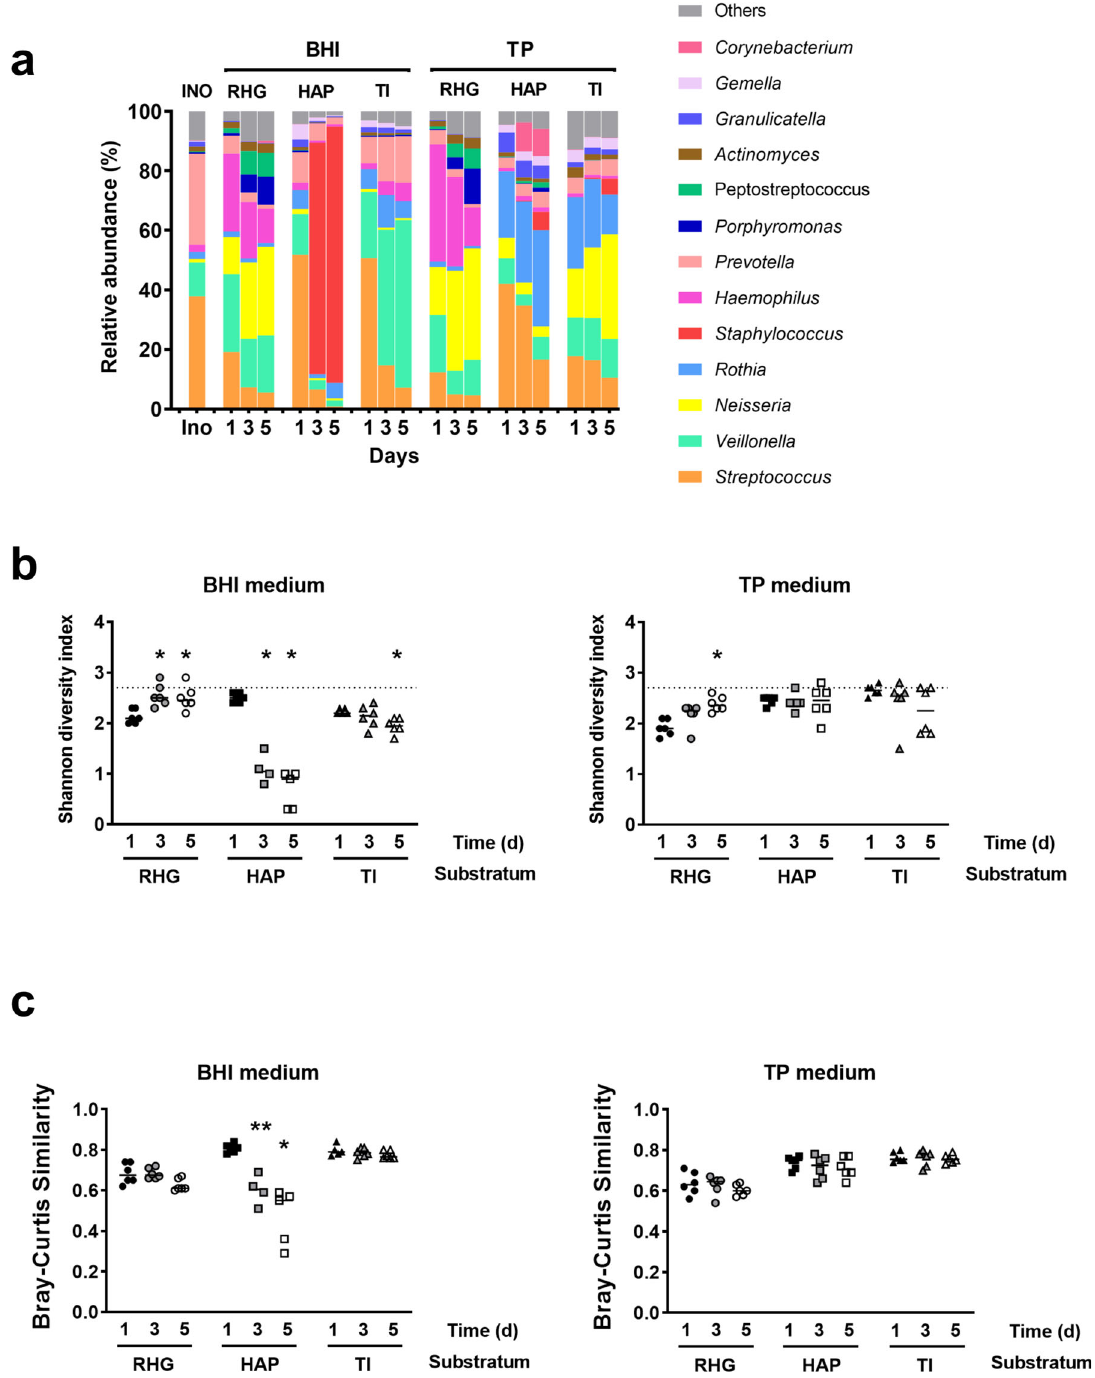
Fig. 2 Microbial pro fi les of microcosm bio fi lms on each oral substratum. a Relative abundance of bacterial genera in microcosm bio fi lms. In total, 13 genera that are found at a relative abundance higher than 1% in any of the samples, were included and counted. The remaining genera are grouped as others. b The Shannon diversity index of microcosm bio fi lms grown in either BHI (left) or TP (right). The dotted line indicates the Shannon index of the saliva inoculum. * represents statistically signi fi cant difference when compared to the day 1 bio fi lms for each condition ( p < 0.05). c Bray-Curtis similarity index between the saliva inoculum and the bio fi lms grown in either BHI (left) or TP (right) medium for 1, 3 and 5 days. * represents statistically signi fi cant difference when compared to the sample pair of day 1 bio fi lms vs. inoculum ( p < 0.05). INO, saliva inoculum; RHG: Reconstructed Human Gingiva; HAP: hydroxyapatite discs; TI: titanium discs. TP: Thompson medium. Data represent the average of 3 independent experiments, each performed in 15 were negative and 114 were positive. The average node degree SPIEC-EASI algorithm, we are able to illustrate the overall microbial was 3.5 (± 1.7). OTU_8, 56, 66 and 72 have the highest number of interaction within the different microcosm bio fi lms (Fig. 4). A total degrees. Using the Girvan-Newman clustering algorithm, a further of 129 microbial interactions were identi fi ed, indicated by the 8 clusters were identi fi ed. Interestingly, the OTUs assigned as number of edges between the nodes. Among these interactions,